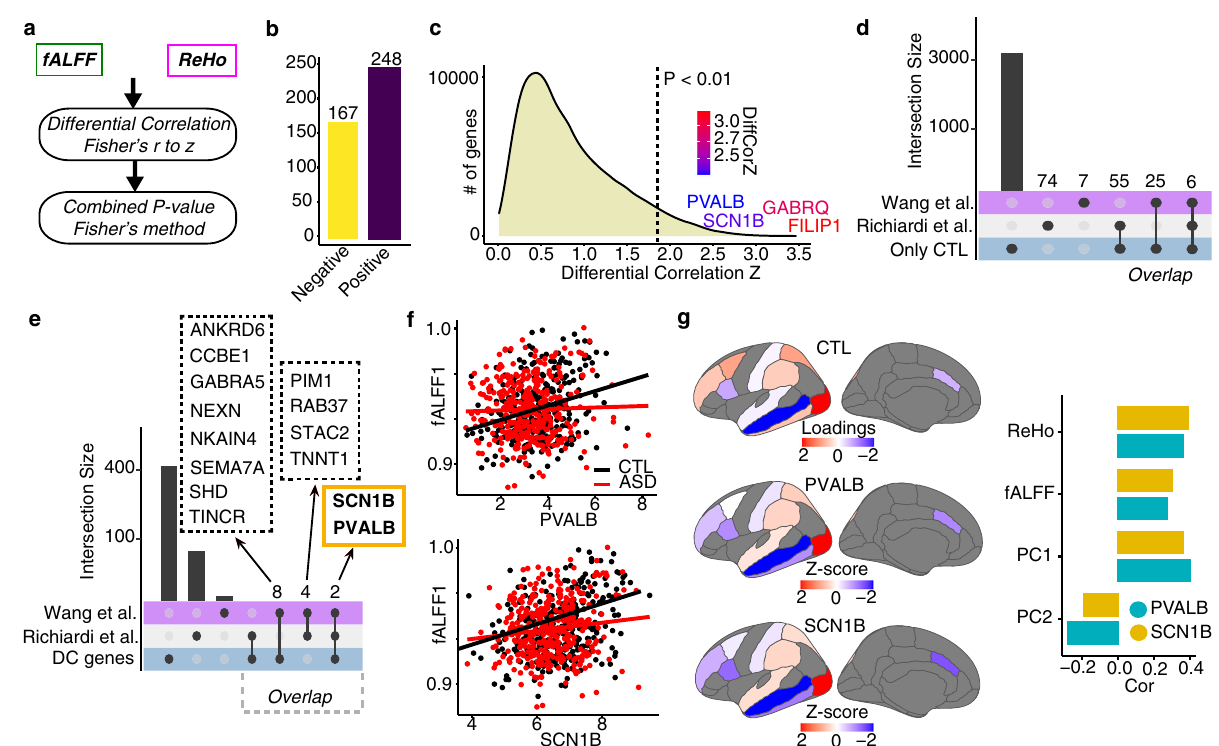
Fig. 3 Overview of differentially correlated genes. a Schematic work fl ow to de fi ne differentially correlated genes. b Barplot depicting the number of differentially correlated genes positively (purple) and negatively (yellow) correlated with CTL. c Density plot depicting the distribution of differential correlation effect sizes (z). Line corresponds to the p value cutoff used. Genes of interest are highlighted with a gradient color that re fl ects the relative effect size. P -value threshold for Differential Correlation analysis is shown based on Fisher ’ s combined P -value. d Upset plot showing the intersection between the genes signi fi cantly correlated only in CTL for both fALFF and ReHo and two previous rs-fMRI — gene expression studies using only data from neurotypical individuals. e Upset plot showing the intersection between DC genes and two previous rs-fMRI — gene expression studies using only data from neurotypical individuals. f Scatterplots showing the relationship (Spearman ’ s rank correlation) between rs-fMRI ( Y -axis) and gene expression for two candidate genes ( X -axis) in CTL and ASD. g Gradient of CTL expression (PC1), PVALB, and SCN1B gene expression. Bar plot depicts the correlation between PVALB and SCN1B gene expression with ReHo, fALFF, expression PC1, and expression odds ratio (OR) = 17.3, FDR = 2.5 × 10 − 15 , Richiardi et al.: OR = 3.2, FDR = 1.5 × 10 − 10 ; Fig. 3d, Supplementary Fig. 5d).